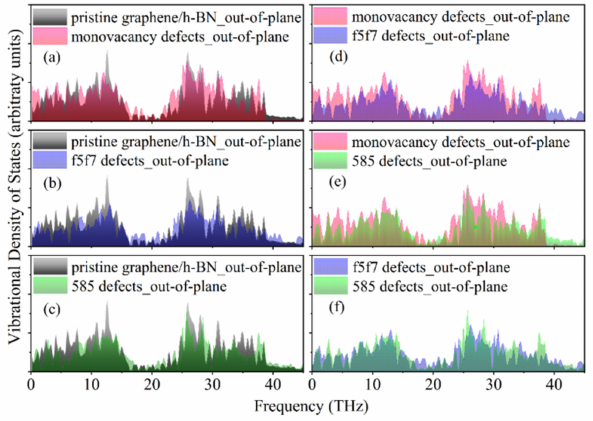
Figure 7. Comparison of the out-of-plane VDOS results in the near-interface regions of pristine graphene/h-BN and defective graphene/h-BN: ( a ) pristine graphene/h-BN and graphene/h-BN with monovacancy defects; ( b ) pristine graphene/h-BN and graphene/h-BN with f5f7 double- vacancy defects; ( c ) pristine graphene/h-BN and graphene/h-BN with 585 double-vacancy defects; ( d ) graphene/h-BN with monovacancy defects and graphene/h-BN with f5f7 double-vacancy de- fects; ( e ) graphene/h-BN with monovacancy defects and graphene/h-BN with 585 double-vacancy defects; ( f ) graphene/h-BN with f5f7 double-vacancy defects and graphene/h-BN with 585 double- vacancy